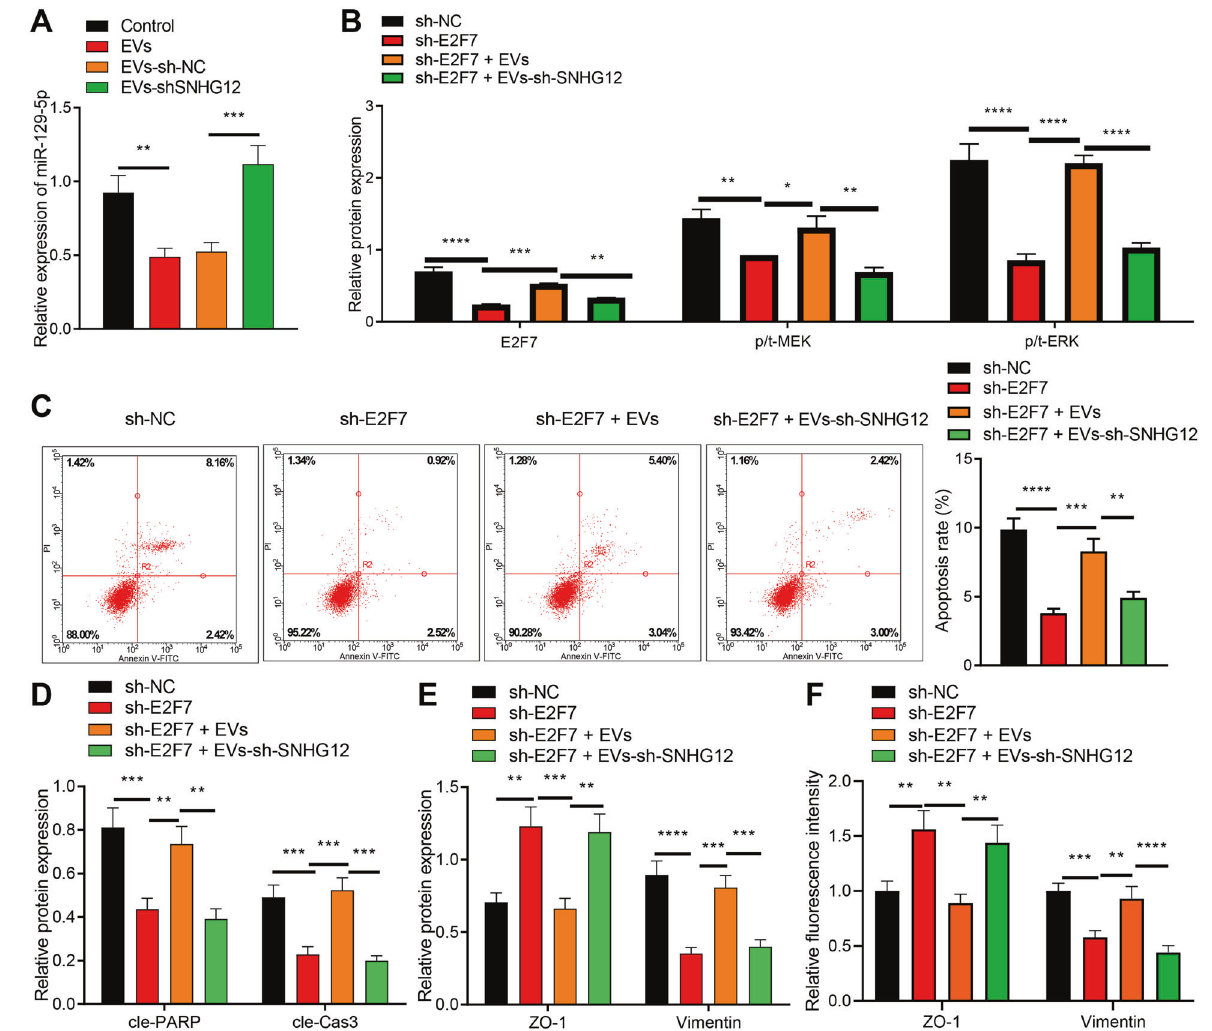
detected using western blot analysis. C Apoptosis of HPMCs after co-culture examined using fl ow cytometry. D The expression patterns of cleaved PARP and caspase-3 in HPMCs after co-culture examined by western blot analysis. E The expression patterns of ZO-1 and Vimentin in HPMCs after co-culture determined using western blot analysis. F The expression patterns of ZO-1 and Vimentin in HPMCs after co-culture determined using immuno fl uorescence. * p < 0.05, ** p < 0.01, *** p < 0.001, **** p < 0.0001. The experiment was conducted three times